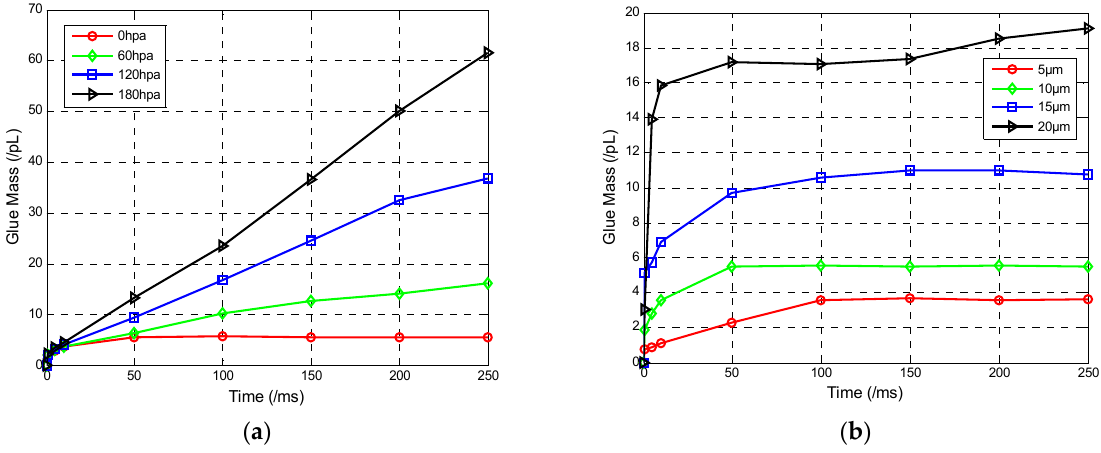
Figure 7. Simulation results: ( a ) pressure versus glue mass, ( b ) diameter versus glue mass. (2) Influence of dispensing needle diameter on glue mass: For the condition of 0 hPa